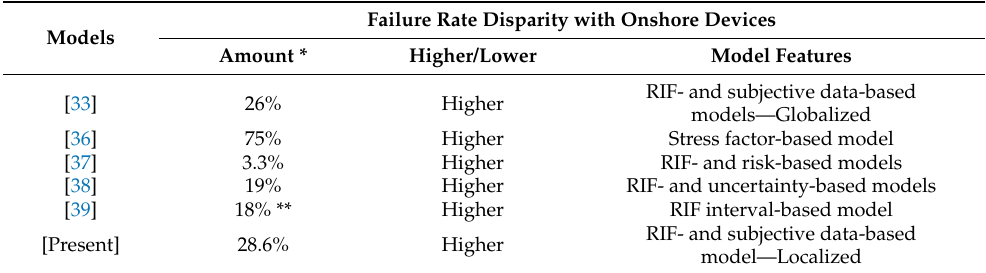
Table 13. Comparison of failure rates of elements assessed using failure correction models.